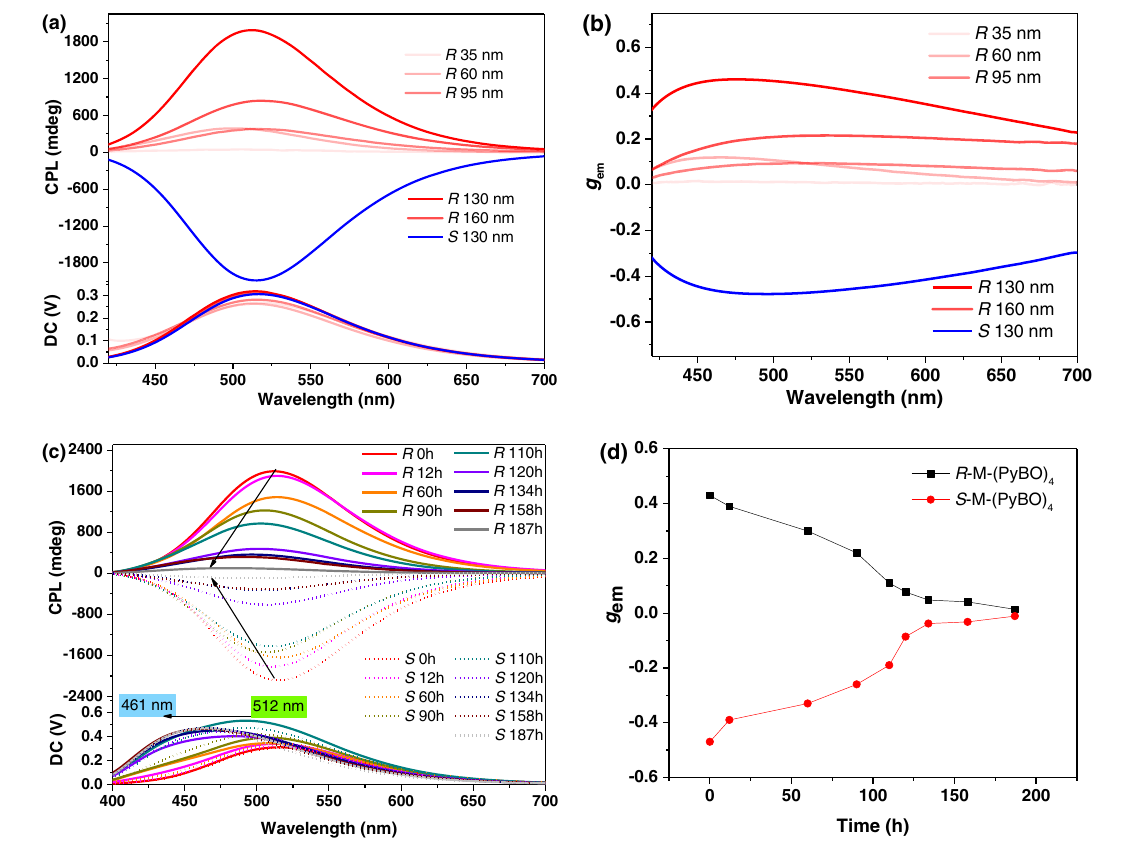
Fig.3|CPLpropertiesatdifferentconditions.a CPLspectraand b the g em values of chiral co-assembly R / S -M-(PyBO) 4 prepared by spin-coating in toluene solutions atdifferentconcentrations; c CPLspectraand d the g em valuesof R / S -M-(PyBO) 4 vs